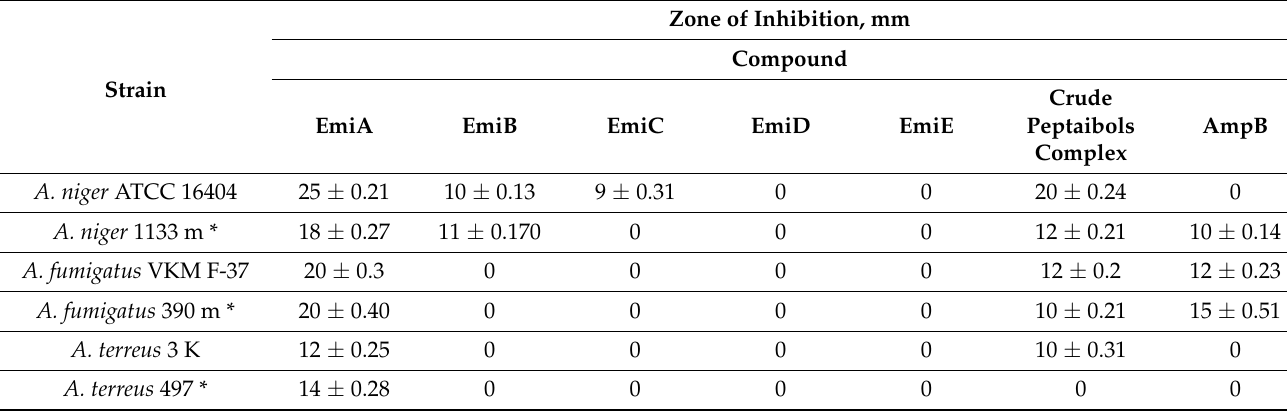
Table 3. Biological comparison data of crude peptaibols extract and pure emericellipsins on clinical and opportunistic mold fungi isolates (40 µ g/disc).